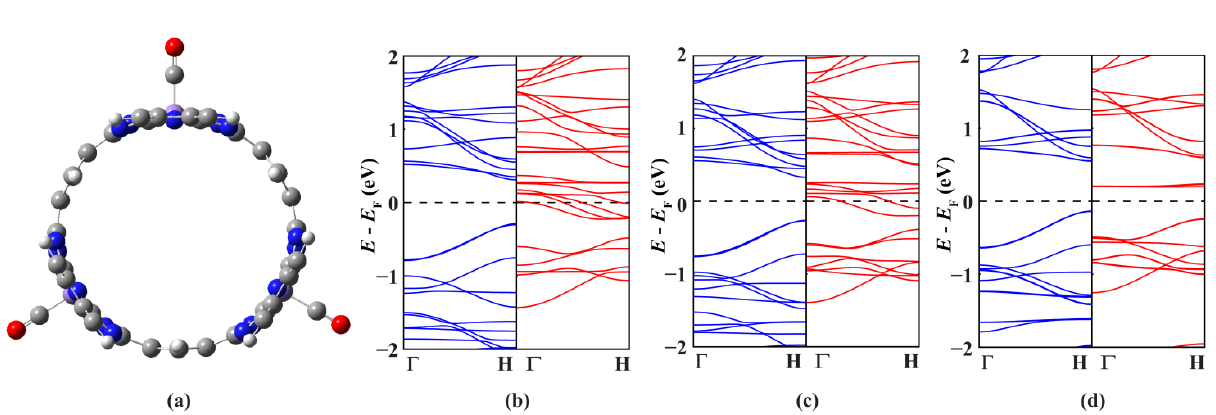
Figure 3. ( a ) the optimized geometry structure of one unit cell of the MnPc-3 nanotube adsorbed with three CO molecules, and the spin-resolved band structures of the MnPc-3 nanotube adsorbed with one ( b ); two ( c ) and three ( d ) CO